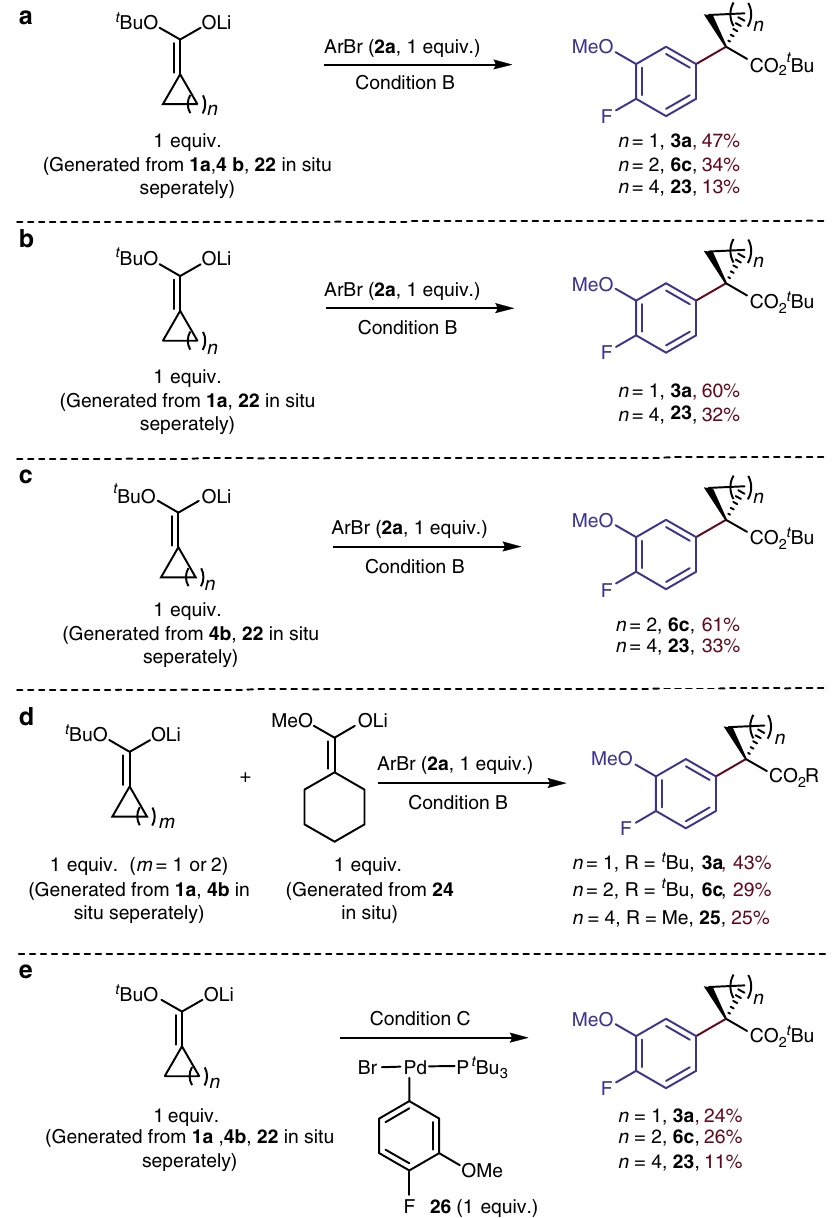
Fig. 8 Studies on transmetallation. a Competition experiments among enolates of cyclopropyl, cyclobutyl and cyclohexyl t -butyl esters. b Competition experiments among enolates of cyclopropyl, and cyclohexyl t -butyl esters. c Competition experiments among enolates of cyclobutyl and cyclohexyl t -butyl esters. d Competition experiments among enolates of cyclopropyl, cyclobutyl t -butyl esters and cyclohexyl methyl esters. e Competition experiments among enolates of cyclopropyl, cyclobutyl and cyclohexyl t -butyl esters with 26 as catalyst. Condition B: ester ( 1a , or 4b , or 22 , or 24 , 1 equiv.) with LiNCy